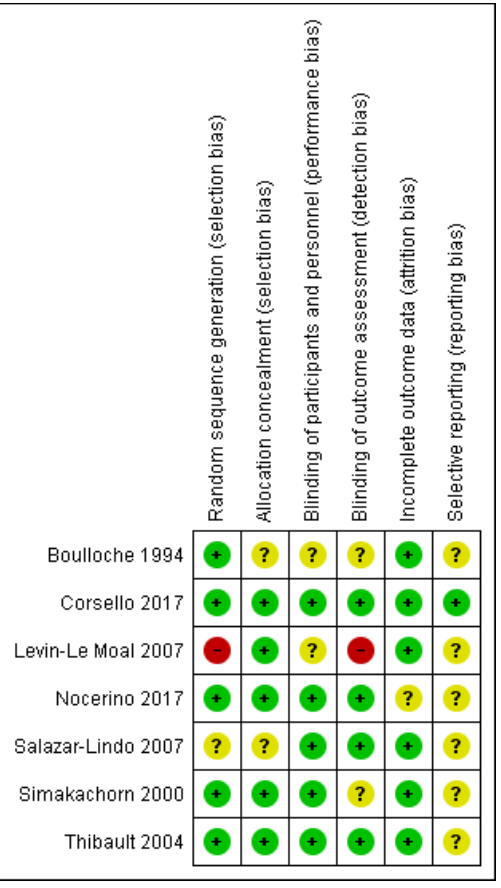
Figure 2. Risk of bias in the indclued studies.